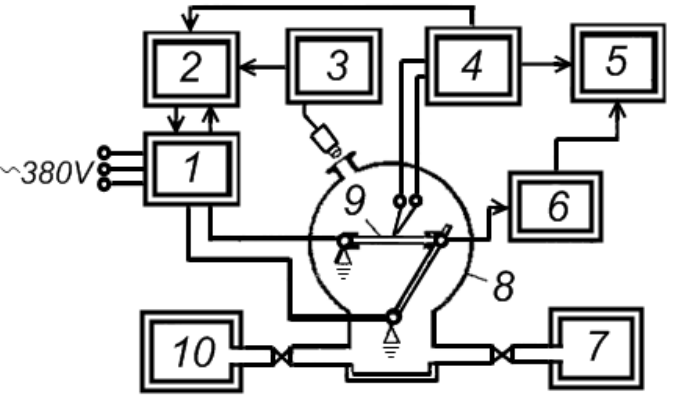
Figure 15. Principle scheme of the electric contact sintering set-up: 1—power unit; 2—control unit; 3—photoelectric pyrometer; 4—temperature recording unit; 5—recording potentiometer; 6—electrical dilatometer; 7—gas system; 8—working chamber; 9—sample; and 10—vacuum